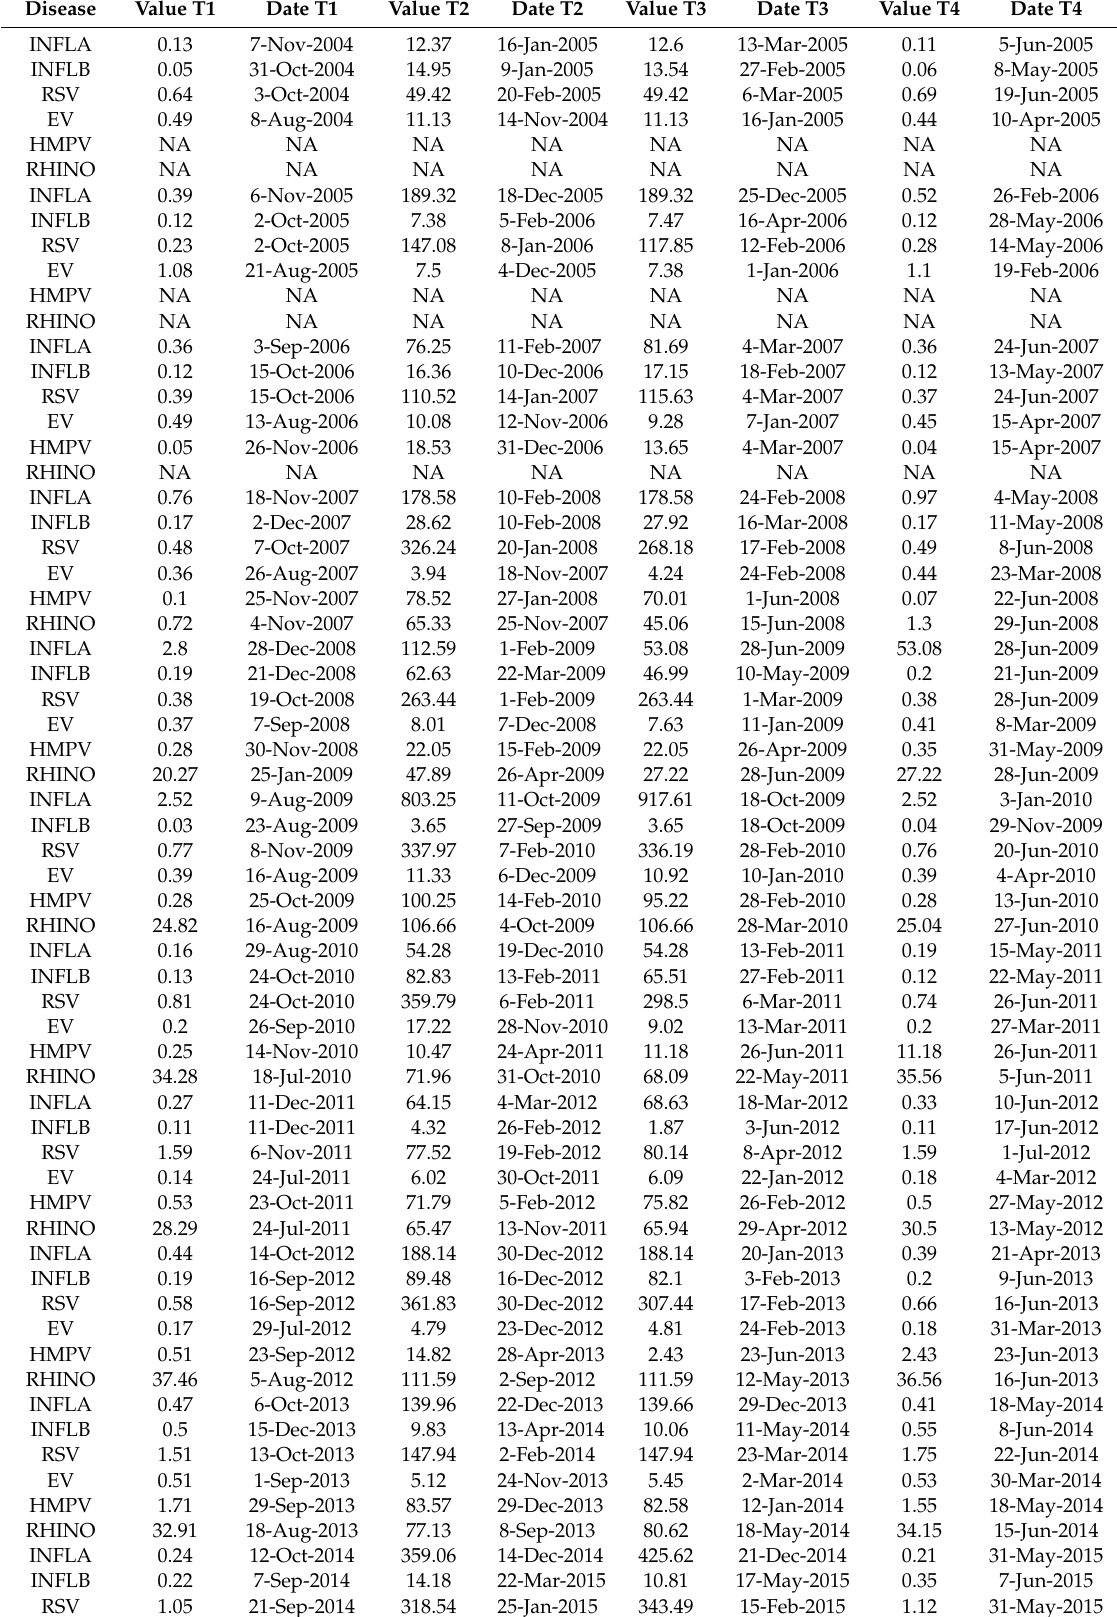
Table A3. Virus mean count change